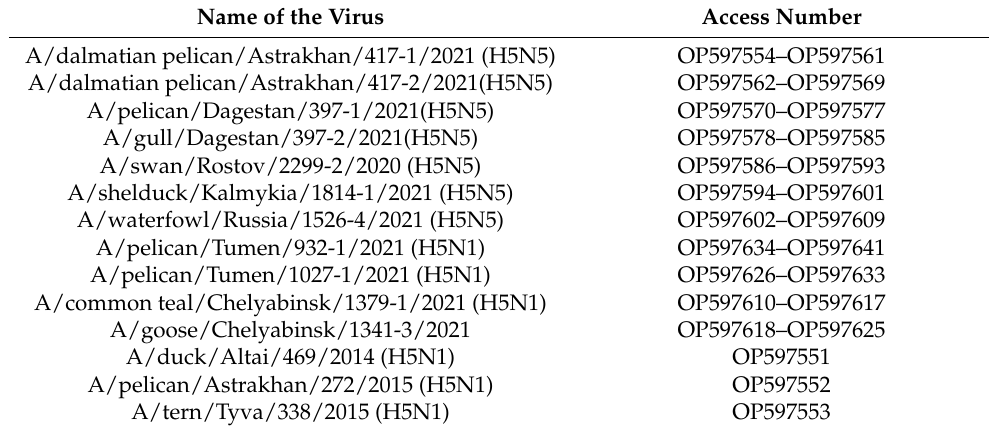
Table 1. Access numbers for the viral genome segments deposited in GenBank. Name of the Virus Access